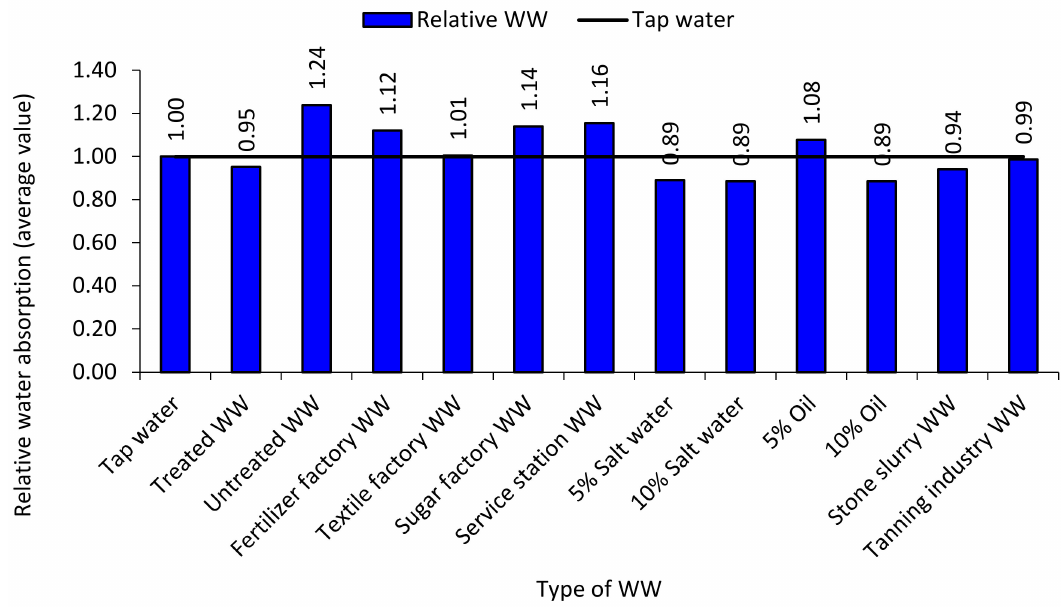
Figure 17. Effect of different types of WW on the water absorp + tion of concrete relative to that of potable water